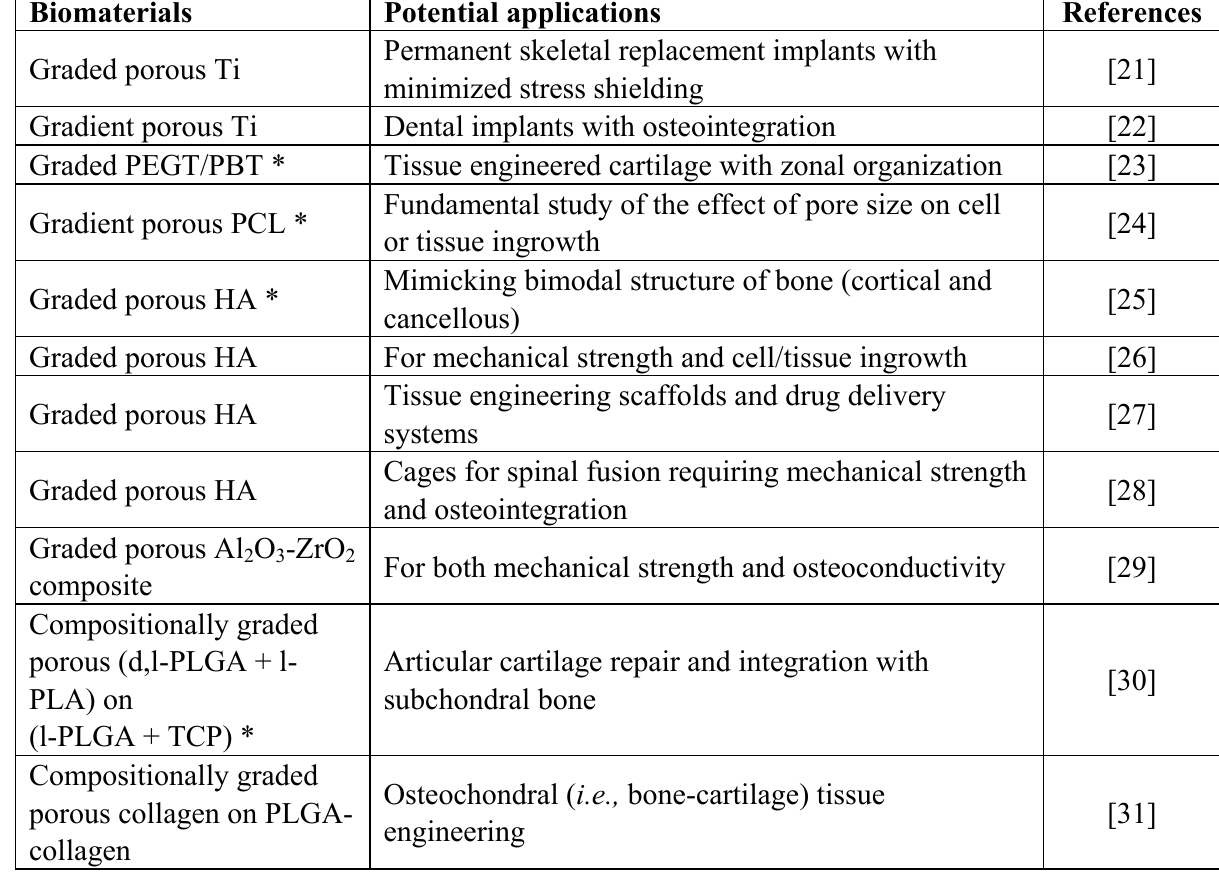
Table 1. Examples of graded/gradient porous biomaterials and their potential